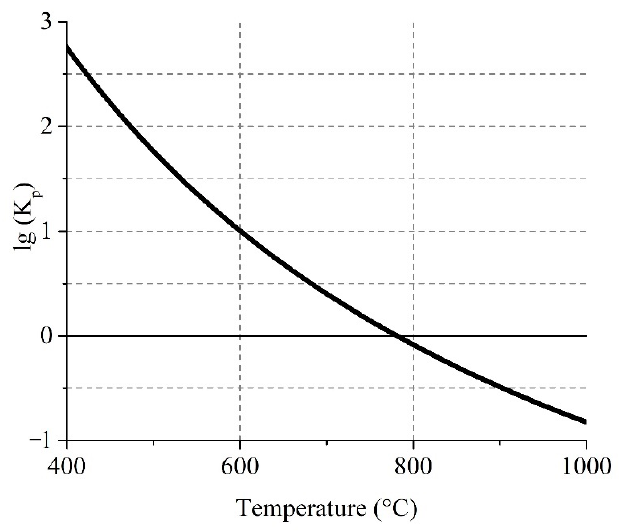
Figure 6. Effect of temperature on the logarithm of the equilibrium constant of the reversible reaction (6).